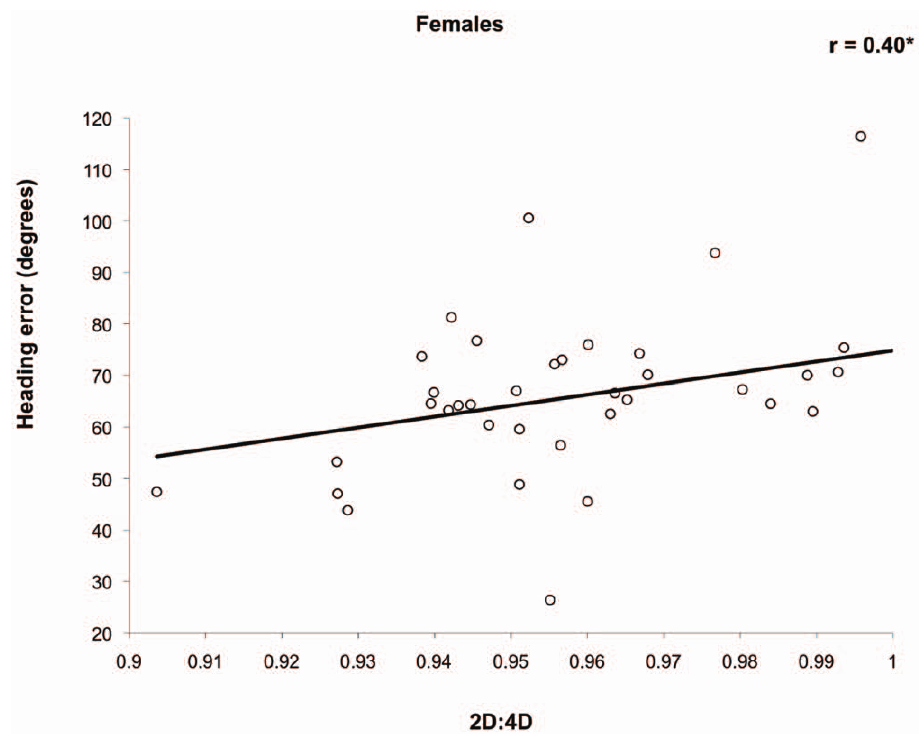
Figure 4. Correlation of digit ratio with virtual navigation initial heading error in females.